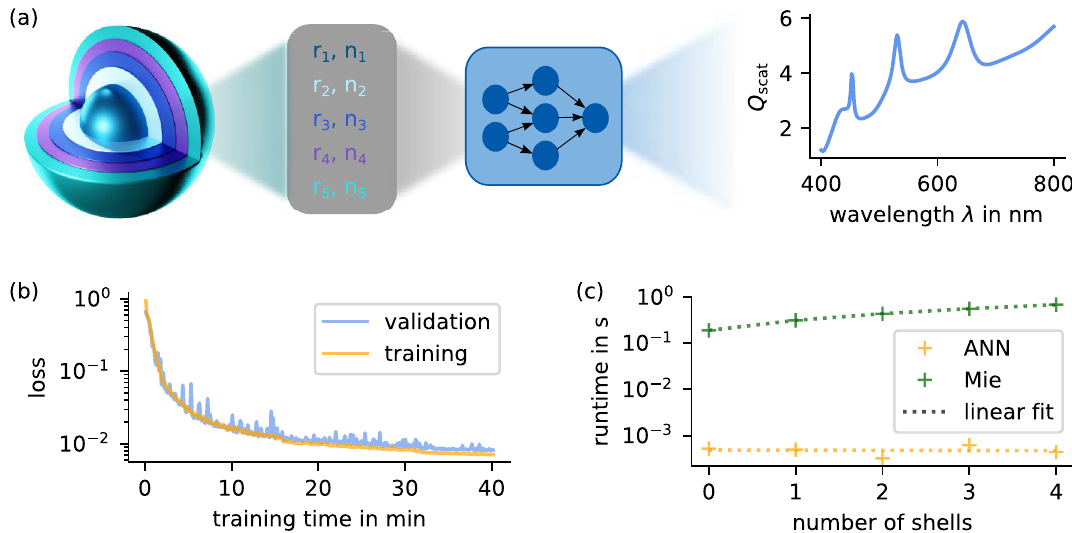
Figure 1. ( a ) Forward approximation of elastic scattering response of a core-multi-shell-particle with an artificial neural network. The particle is parametrized in five geometrical and five material parameters that comprise the network’s input. Subsequently, the network predicts the scattering efficiency at 200 wavelengths within a spectral interval between 400 nm and 800 nm. ( b ) Training and validation loss with a final MSE of 8.24 × 10 − 3 . ( c ) Runtime comparison of analytical calculation using Mie-theory and ANN approximation.